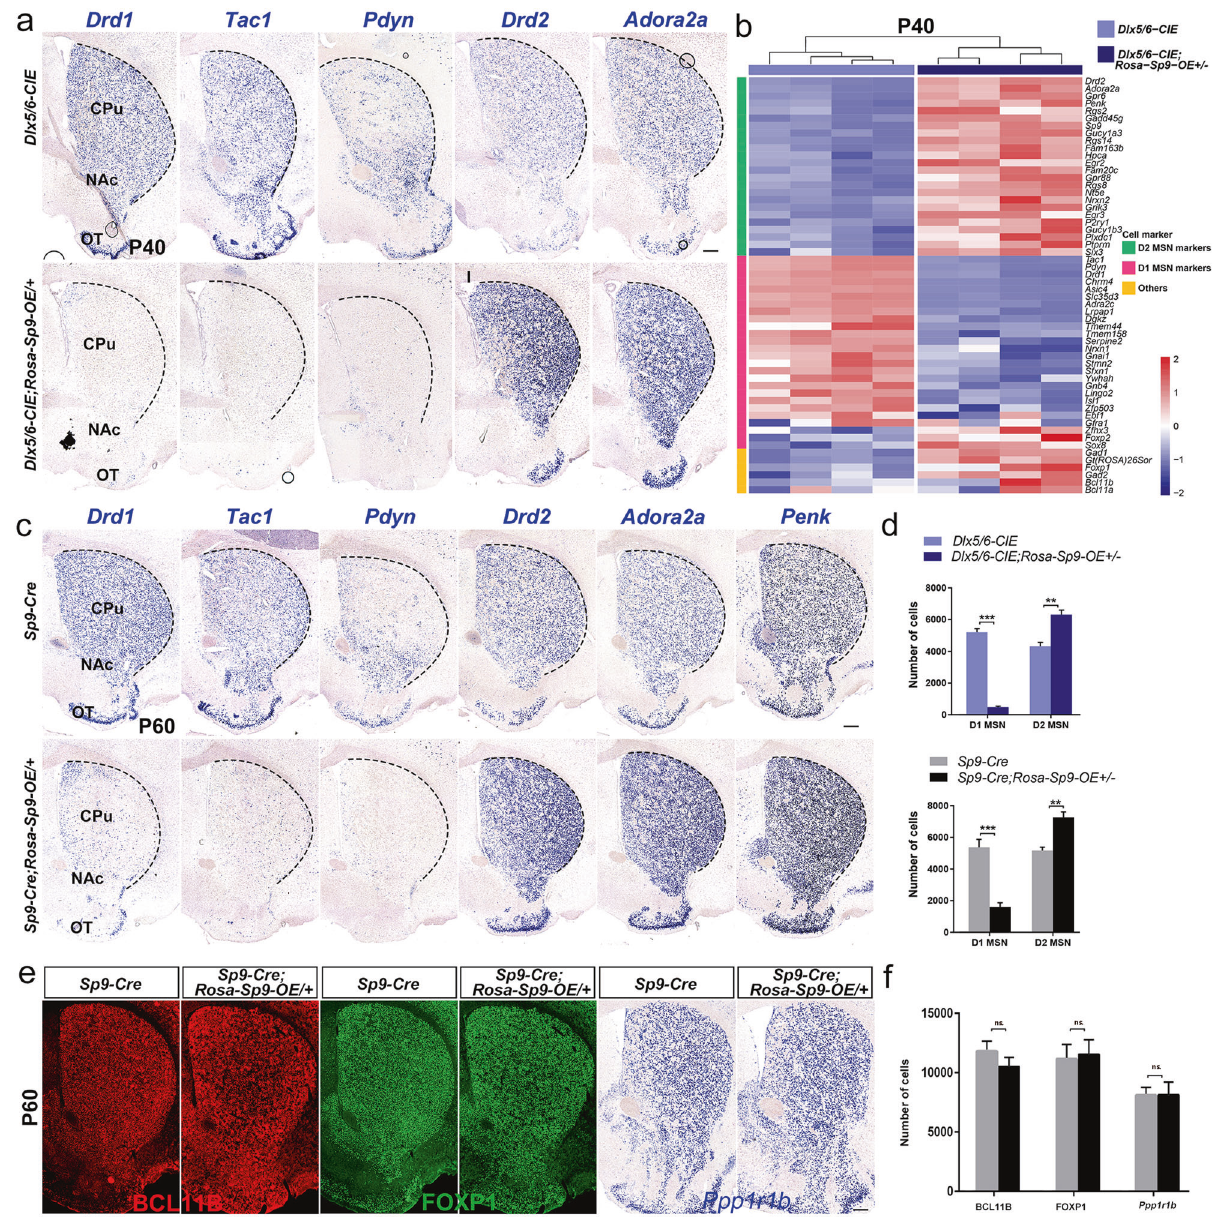
Fig. 8 D2-like MSNs survive in the adult brain. a , d In situ RNA hybridization of Drd1 , Tac1 , Pdyn , Drd2, Adora2a and Penk showing that the number of D1-MSNs was decreased by ~91% and that the number of D2-MSNs was increased by ~46% in the striatum of the Dlx5/6-CIE; Rosa- Sp9-OE/ + mice compared to the control mice at P40. b Heatmap showing the expression levels of MSN-enriched genes in the striatum of Sp9- Cre; Rosa-Sp9-OE/ + and Sp9-Cre striatum on P40 (obtained by bulk RNA sequencing). c , d In situ RNA hybridization showing that the number of D1-MSNs was decreased by ~71% and that the number of D2-MSNs was increased ~40% in the striatum of the Sp9-Cre; Rosa-Sp9-OE/ + mice compared to control mice on P60, indicating that D2-like MSNs exhibit long-term survival. e , f The expression of BCL11B, FOXP1 and Ppp1r1b (three pan-striatal MSN markers) was similar in the Sp9-Cre; Rosa-Sp9-OE/ + and control mice. (Student ’ s t -test, ** p < 0.01, *** p < 0.001, n = 3, mean ± SEM). Scale bar: 250 µm in e for a , c , e